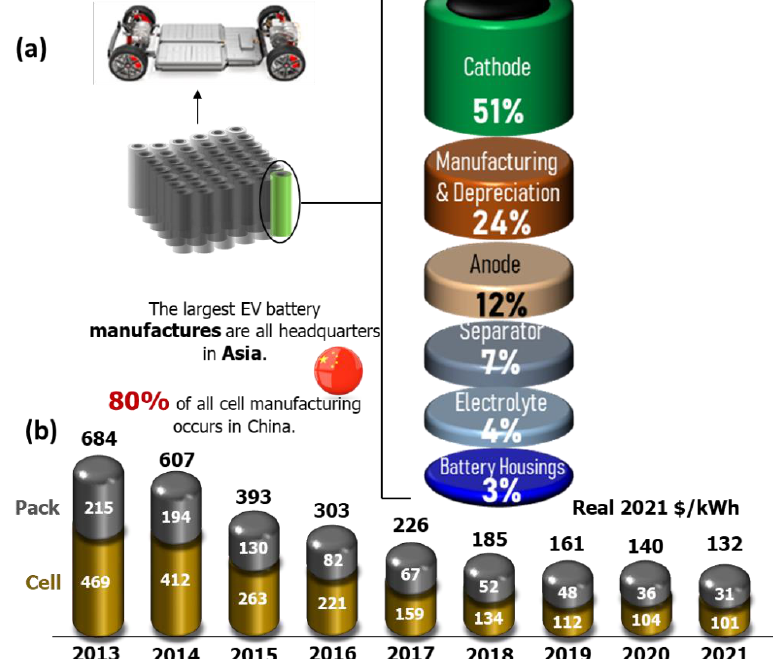
Figure 2. ( a ) Schematic breaking down the cost of an EV battery cell [5]. ( b ) Volume-weighted average pack and cell price split. Adapted with permission from Ref. [6]. Copyright 2022 Copyright